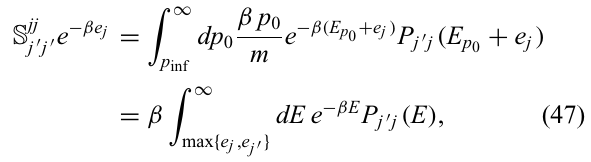
FIG. 2. Thermalization via collisions is achieved if the sys- tem (scatterer) is bombarded by narrow wave packets coming from equilibrium reservoirs at the two sides. If we remove one of the reservoirs, the setup is out of equilibrium. Notice however that, if the scatterer is symmetric, that is, if the interaction poten- tial V ( x ) is even, V ( x ) = V ( − x ) , then the second reservoir is not